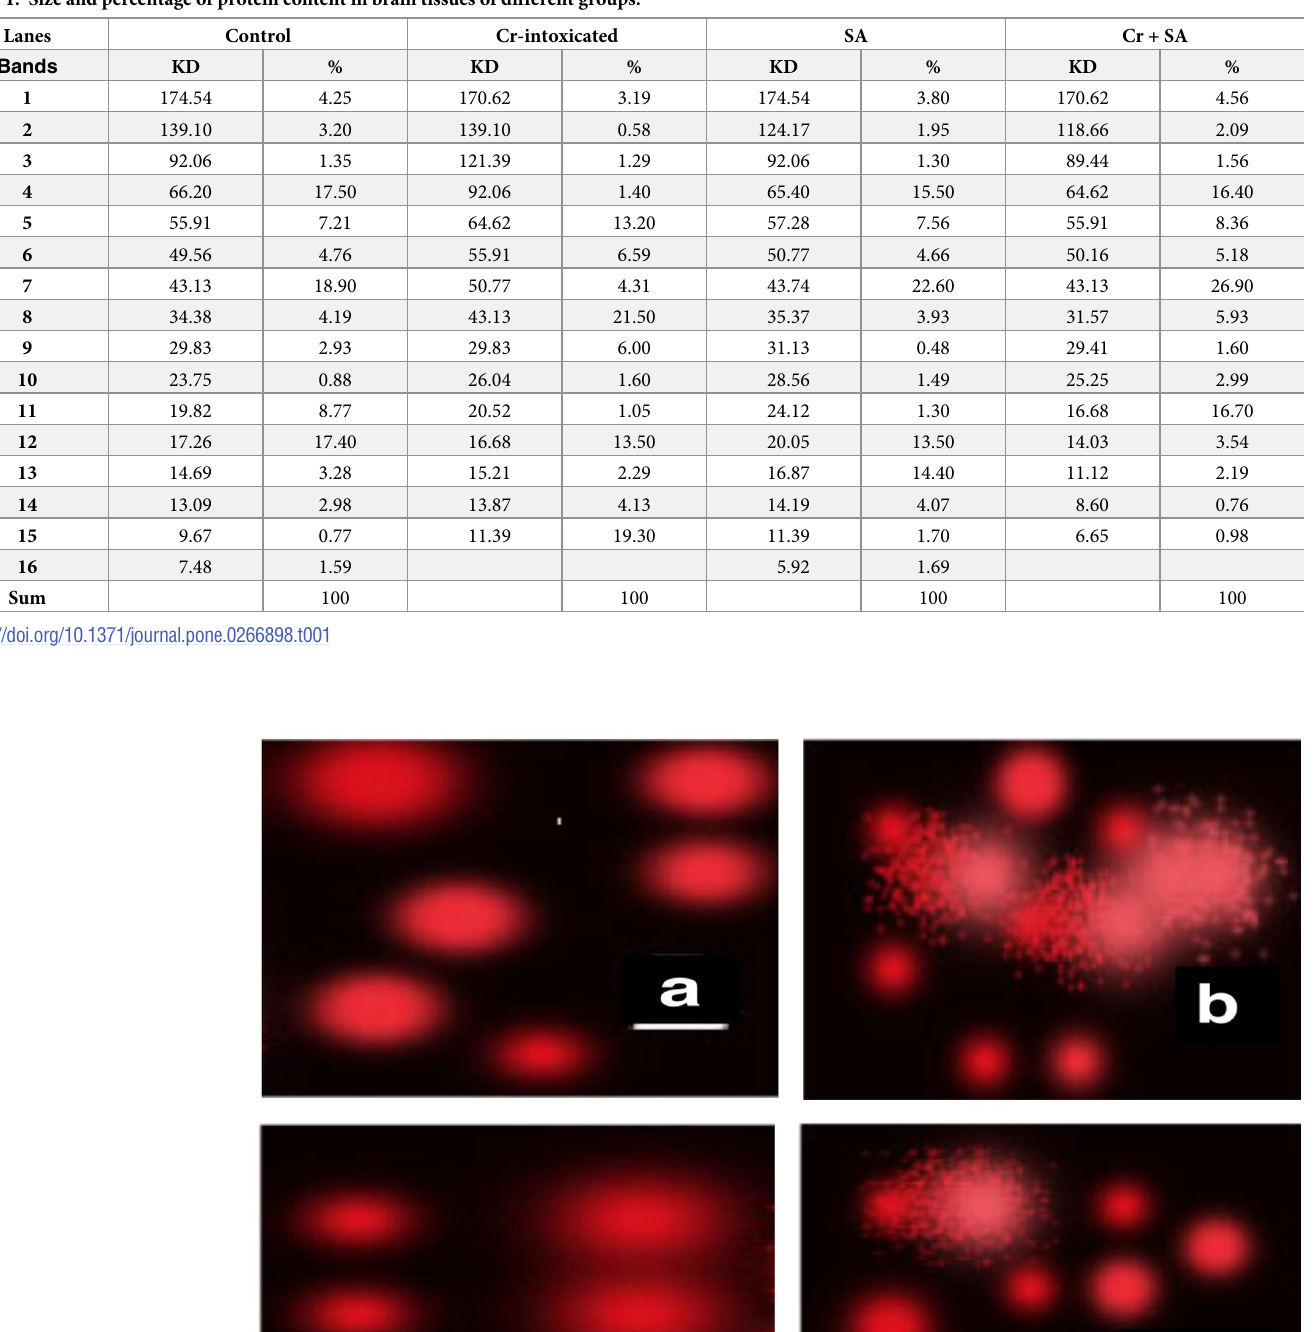
Table 1. Size and percentage of protein content in brain tissues of different groups.